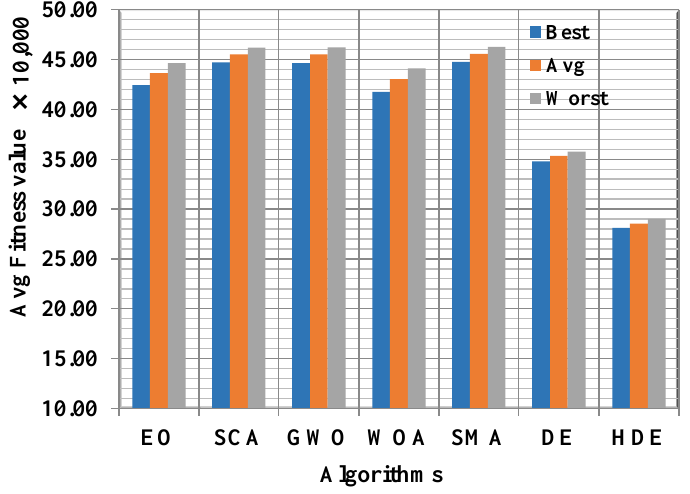
Figure 8. Comparison among algorithms for the total execution time.